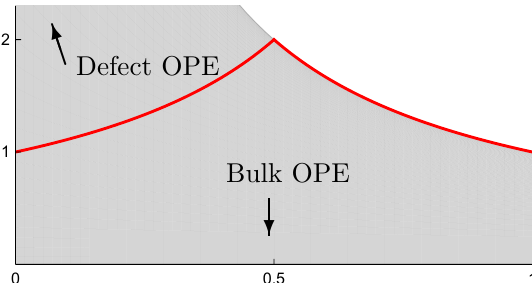
Figure 6 . The physical region in ( (cid:24); (cid:16) ) coordinates (in gray) is bounded above by the curve (cid:24) = 1 =(cid:16) , corresponding to cos (cid:30) = 1. The red curve denotes the radius of convergence of the expansion of (cid:0) the bulk channel conformal blocks in powers of (cid:24) : the left branch has equation (cid:24) = 1 = (1 subsection